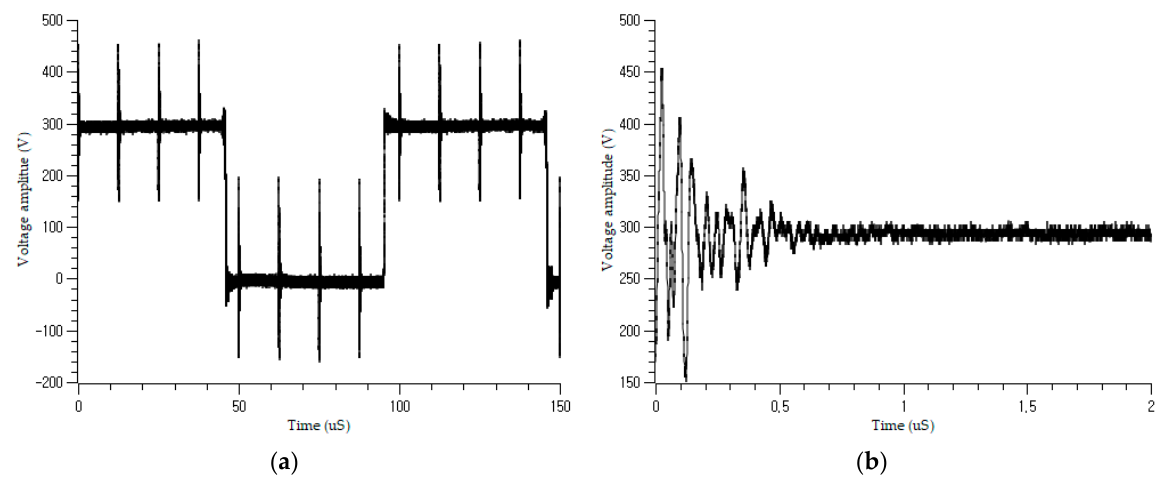
Figure 8. Online burst signal injection on the cable: ( a ) coupled periodic burst signal; ( b ) a single pulse from ( a ).